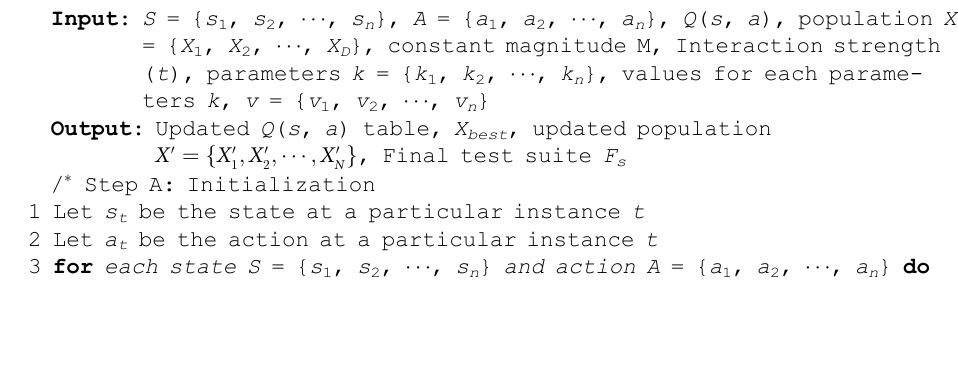
Algorithm 3 : Pseudo Code for the QLSCA Algorithm